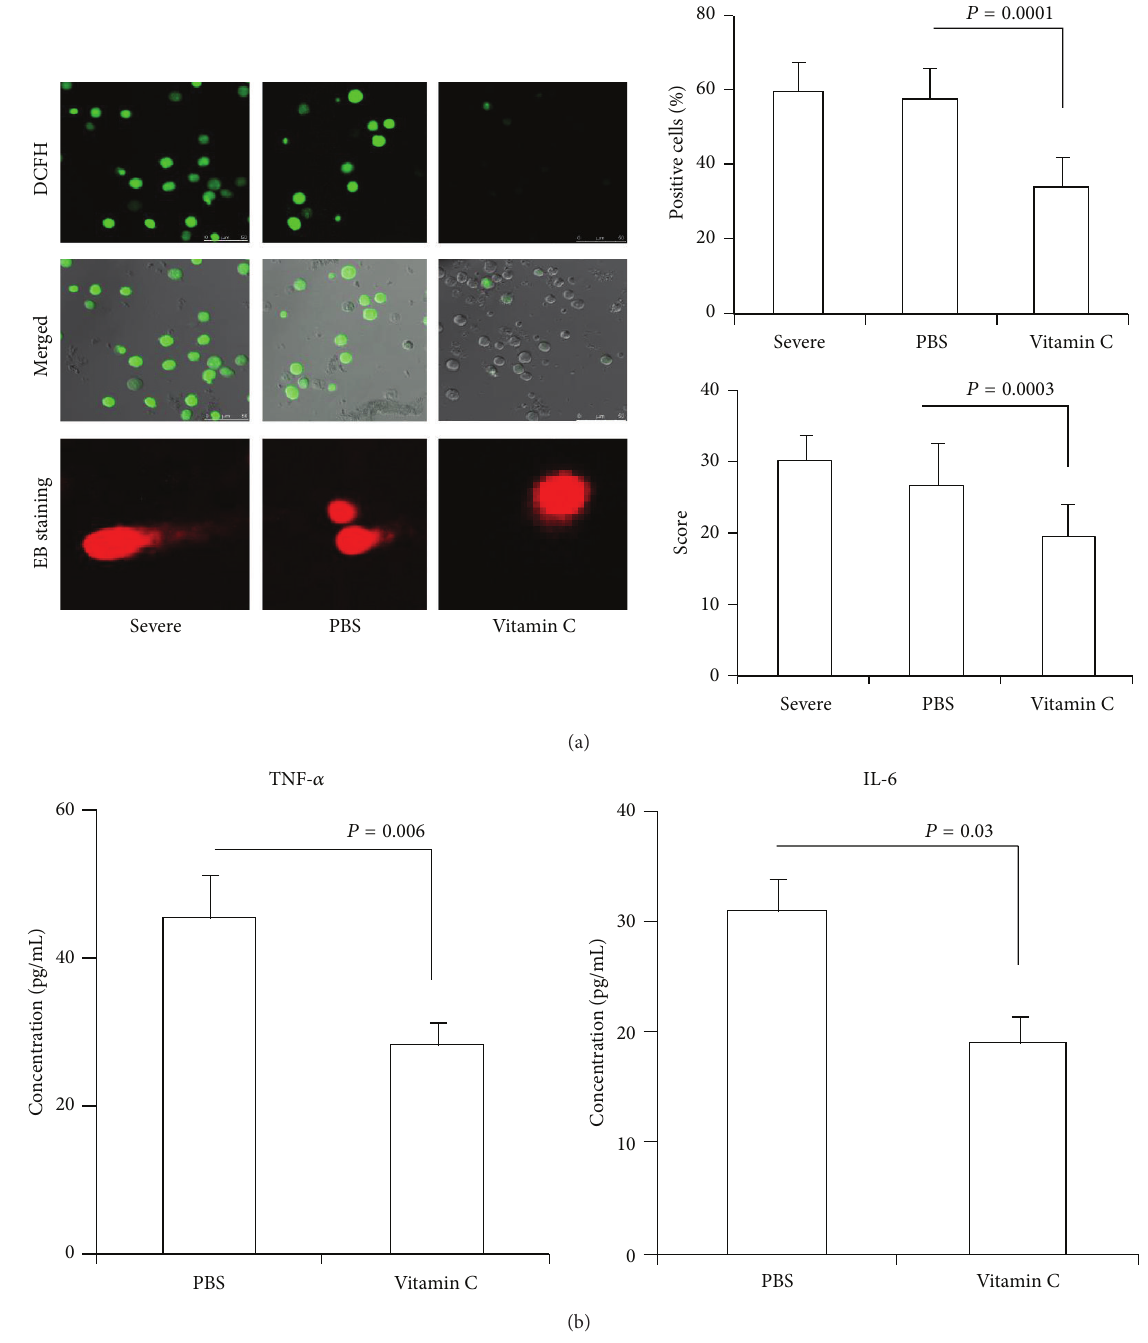
Figure 3: The effect of vitamin C on ROS, DNA damage, TNF- 𝛼 , and IL-6 in vitro . Monocytes from severe CAP were treated with vitamin C for 12 h in vitro. (a) Intracellular ROS were detected by confocal microscope using DHE probe ( × 400). DNA damage was detected by comet assay using confocal microscope ( × 400). (b) Whole blood cells from severe CAP were treated with vitamin C for 12h in vitro. Standard ELISA was performed to determine the levels of TNF- 𝛼 and